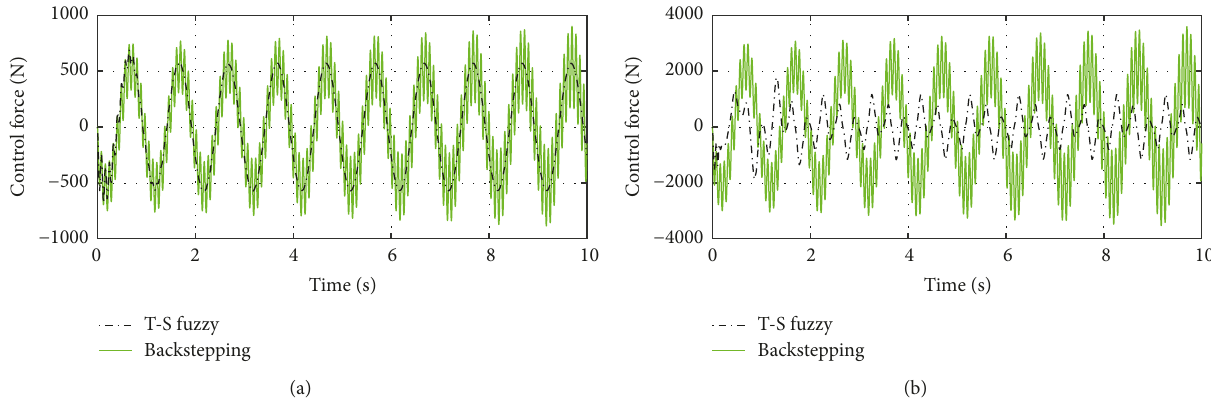
Figure 5: Force produced by the actuator: (a) force produced under mild perturbation; (b) force produced under malevolent perturbation.